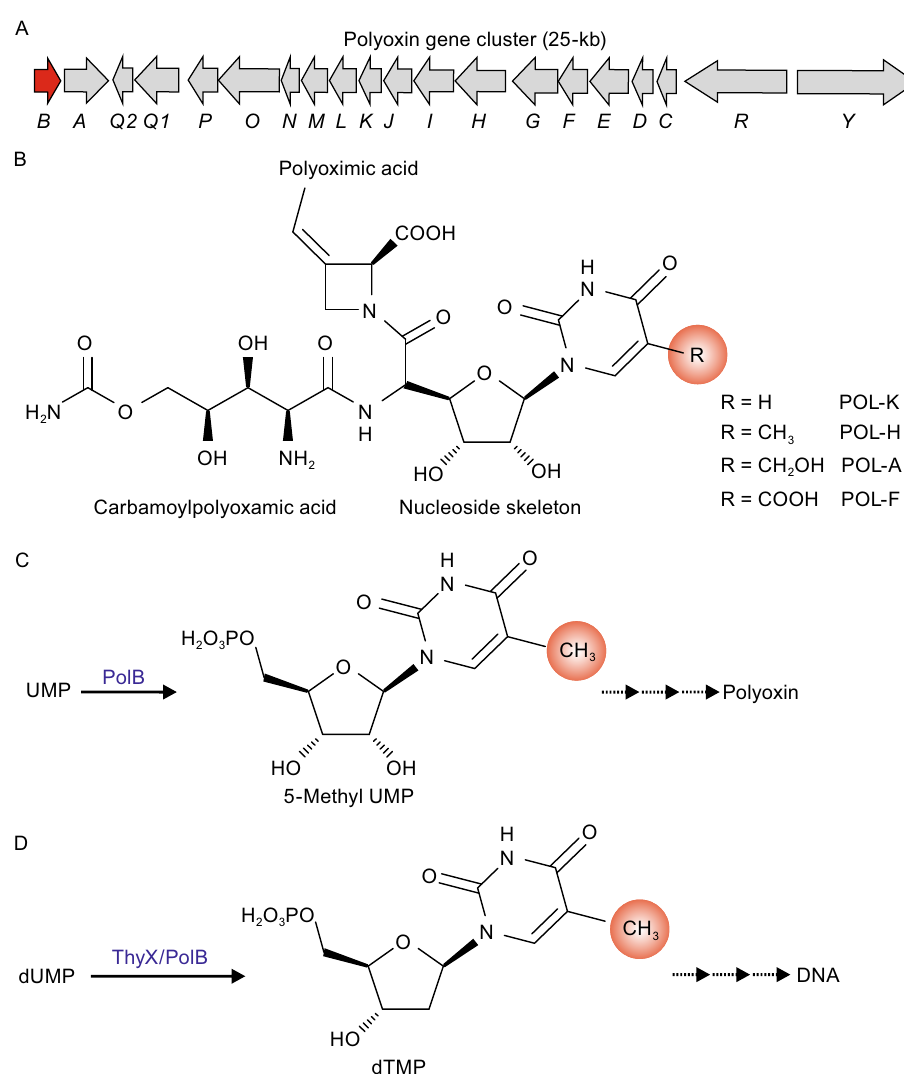
Figure 1. Gene cluster and structure of polyoxin as well as the dual functions of PolB. (A) The genetic organization of the polyoxin gene cluster. (B) The difference of polyoxin A, F, H and K is the C5 modi fi cation in nucleoside skeleton. (C) PolB catalyzes the UMP methylation in polyoxin biosynthesis. (D) ThyX and PolB could catalyze the dTMP biosynthesis. POL: